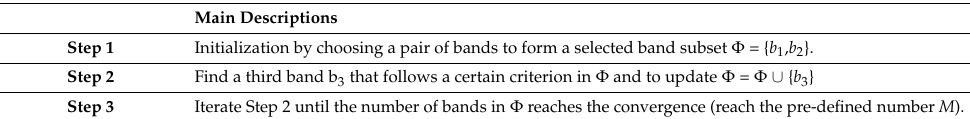
Table 1. Main steps of the band selection algorithms in [10,11].